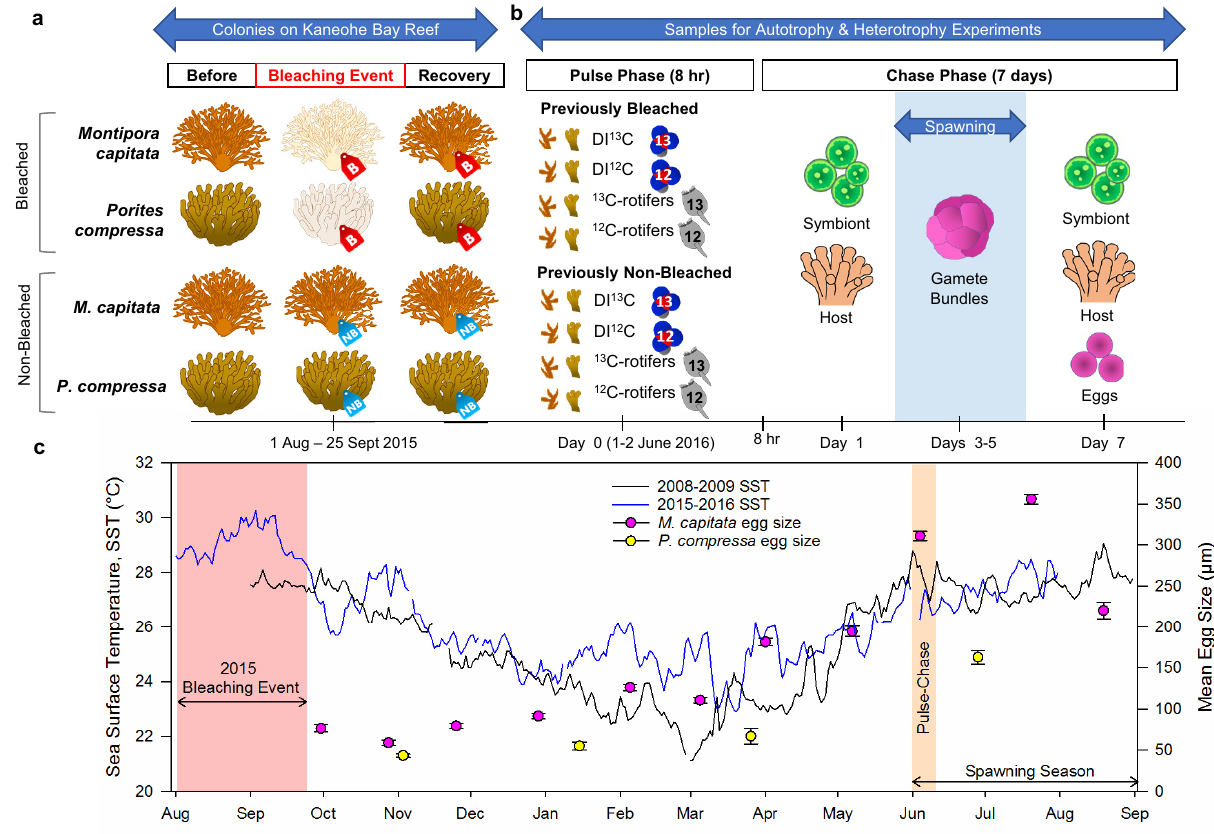
Figure 1. Experimental design and reproductive cycle in Hawaiian corals. ( a ) Bleached and non-bleached colonies were tagged during a bleaching event in Kāne’ohe Bay in Aug-Sept 2015 41 and monitored for 8 months until recovery. ( b ) In June 2016, four fragments were collected from each colony and the pulse phase of the experiment was conducted for 8 h to evaluate carbon acquisition by autotrophy (DI 13 C or DI 12 C) or heterotrophy ( 13 C-rotifers or 12 C-rotifers). Allocation of 13 C was measured during 7 days of a chase phase in symbiont cells, host tissue, and eggs. ( c ) Mean daily sea surface temperature (SST) from NOAA Station MOKH1 (21° 25 ′ 59" N 157° 47 ′ 23" W) for 2008–2009, a non-bleaching year when egg size for Monitpora capitata was previously reported 42 , and 2015–2016, when bleaching occurred. SST is compared to egg size (mean ± standard error) for M. capitata 42 and Porites compressa (Padilla-Gamiño, unpublished